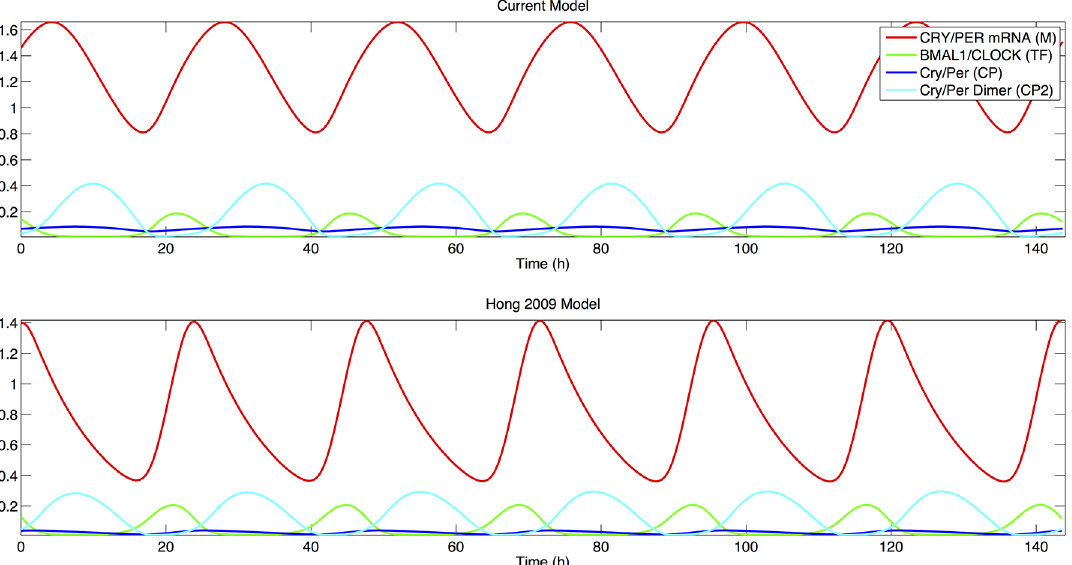
Fig 3. Comparison of current (Top) and Hong 2009 (Bottom) models. Red: CRY/PER mRNA, Green: BMAL1/CLOCK, Blue: CRY/PER protein, Cyan: CRY/PER Dimer. Only species common to both models are included.